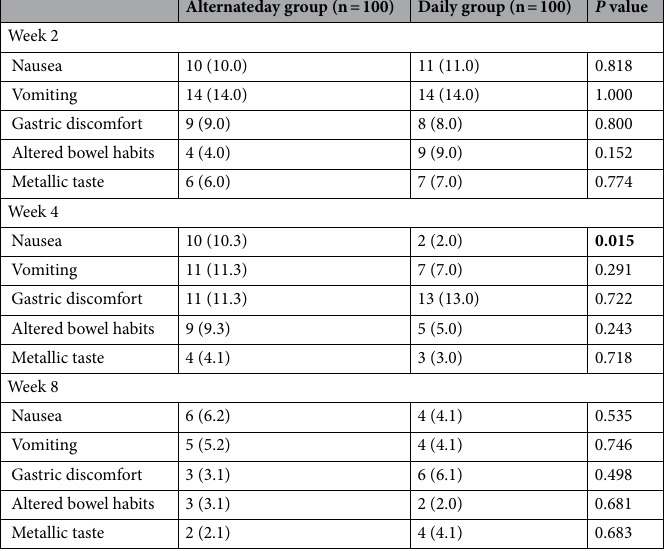
Table 3. Adverse events among participants randomized to daily and alternate day iron therapy. Significant values are in